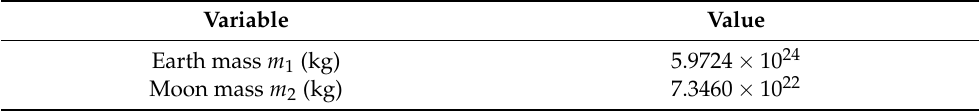
Table 1. Earth–Moon system parameters.